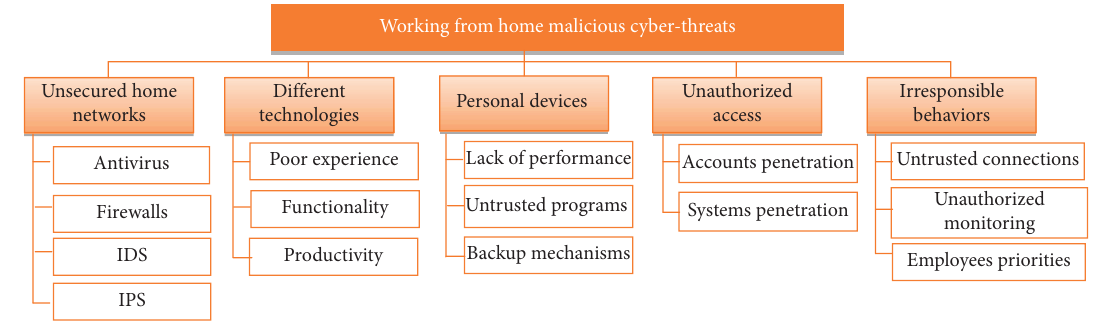
Figure 6: Threats of working from